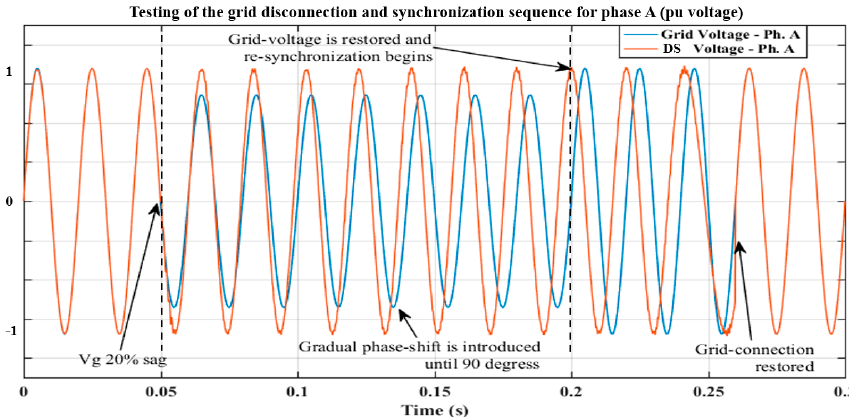
Figure 10. Grid disconnection/re ‐ synchronization sequence.